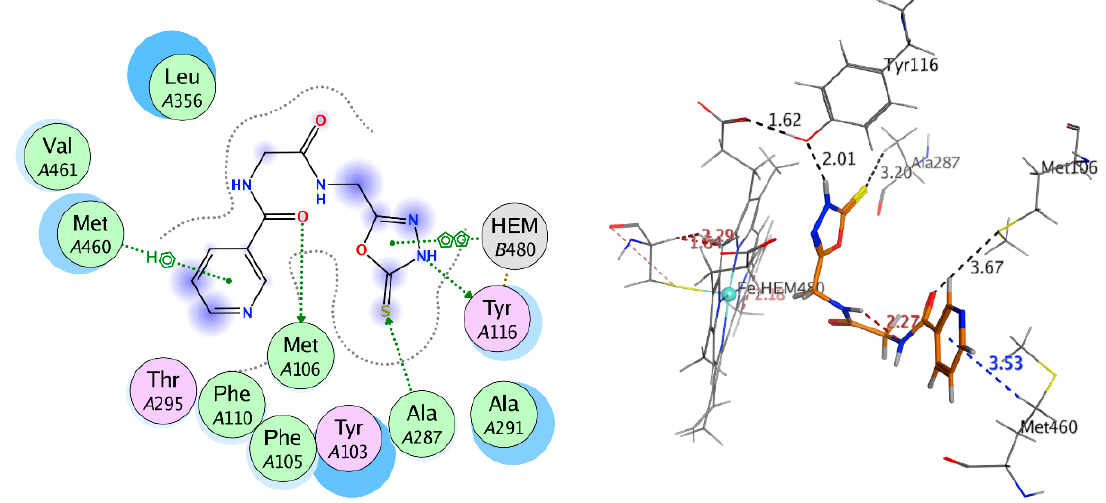
Figure 8. 2D and 3D interaction of compound 9 with 3gw9.